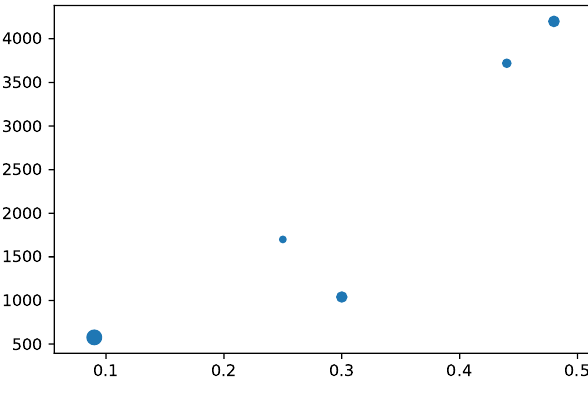
Fig. 90.— Hubble plot with (arbitrarily) varying marker sizes